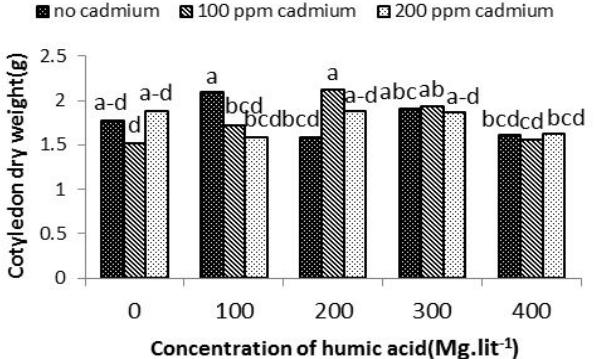
Fig. 7. Effect of humic acid and cadmium concentration on the cotyledon fresh weight of pumpkin seeds